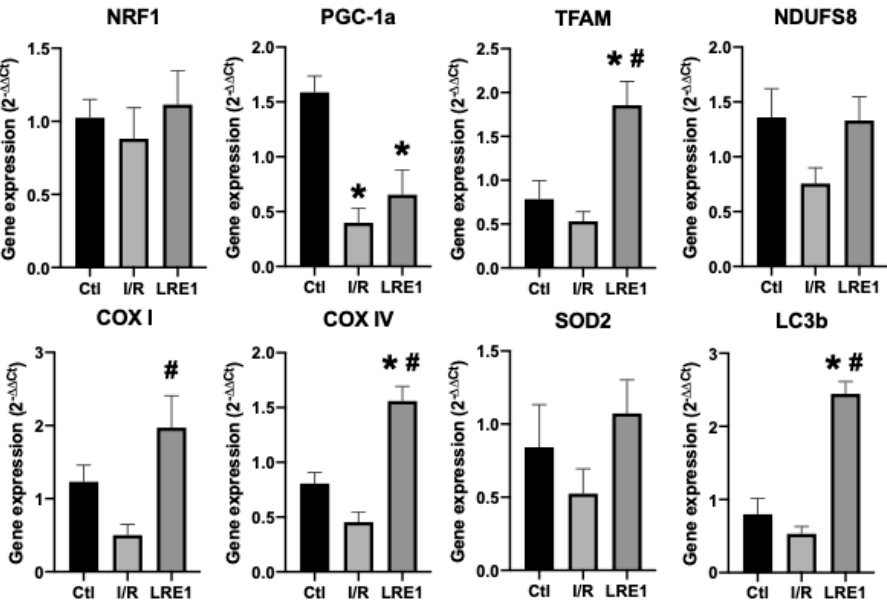
Figure 5. Liver gene expression evaluation by semi-qPCR. Data are means ± SEM of 4 independent experiments. NRF1 , nuclear respiratory factor 1; PGC-1a , peroxisome proliferator-activated receptor gamma, coactivator 1 alpha; TFAM , mitochondrial transcription factor A; NDUFS8 ,